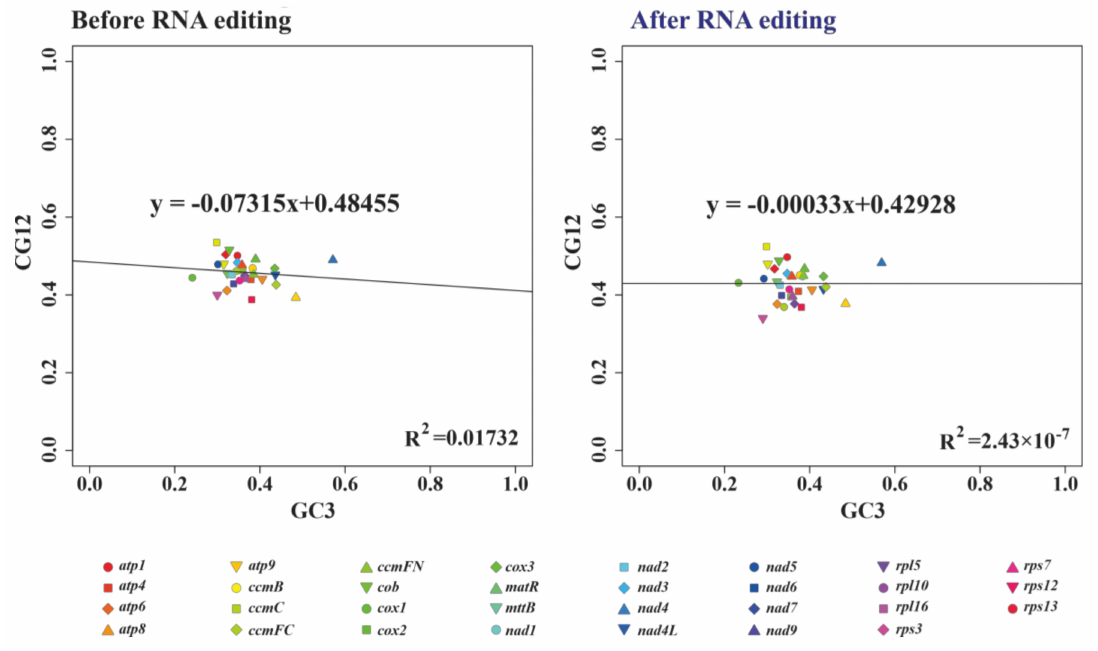
Figure 5. Neutrality plots of mitochondrial PCGs before and after RNA